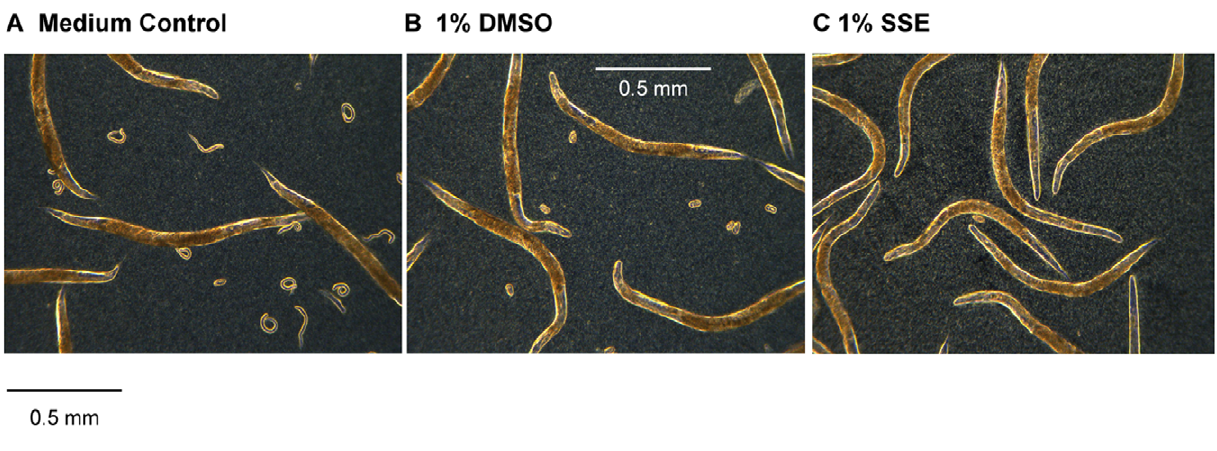
Figure 3. Delayed egg laying at 71.5 h following SSE and DMSO exposure at L1 larval stage. Levamisole anaesthetised worms (1 mM) were photographed with an infinity 2 camera linked to a Leitz Labovert microscope. (A) medium control; (B) DMSO; (C) SSE. Progeny numbers were counted from samples (n=4) taken at 70.4 h and expressed per nematode. Representative of 3 independent experiments carried out at different times.